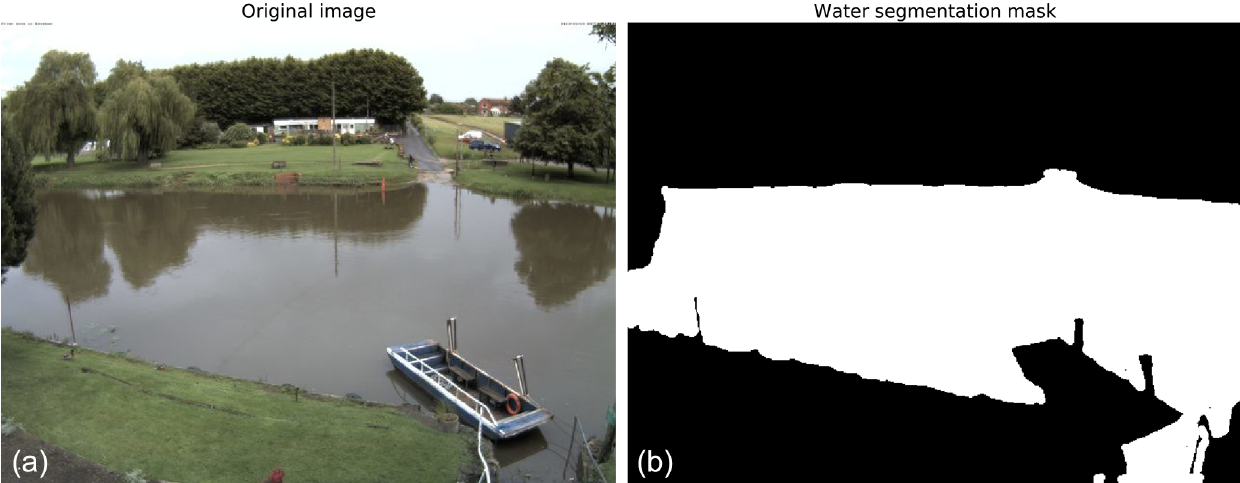
Figure 1. Example of a water segmentation mask (a) for a river-camera image (b) . The mask corresponds to a pixel-wise labelling of the original images between flooded pixels (in white) and unflooded pixels (in black), expressing whether or not there is water present in the pixel.